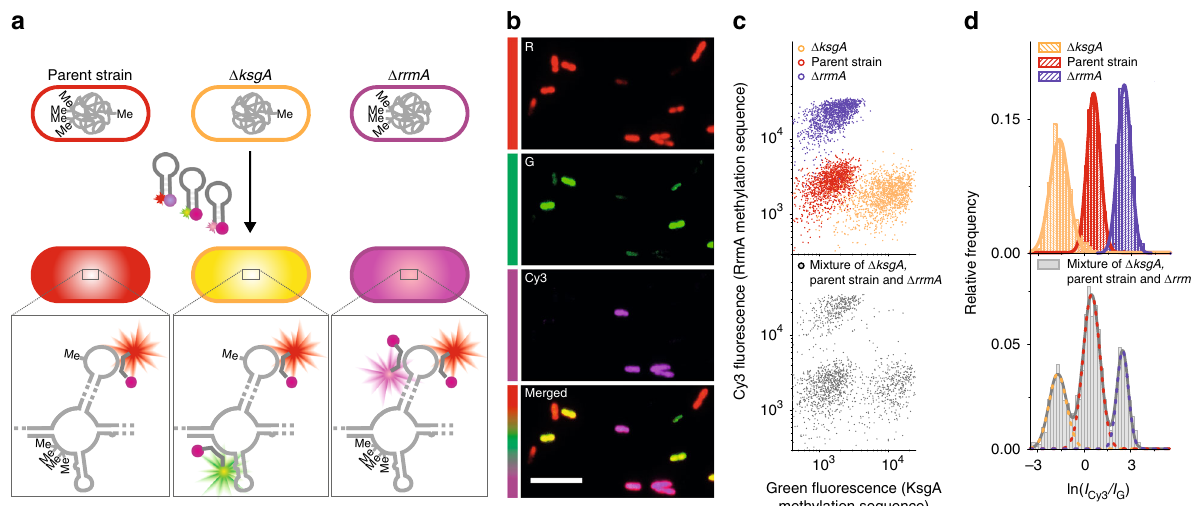
Fig. 4 Multiplexed detection of rRNA methylations with MR-FISH. a Multiplexed assay for two rRNA methylations, using three Molecular Beacons, staining an unmethylated portion of the 23S rRNA (Alexa Fluor 647-labeled), the KsgA methylation sequence (Alexa Fluor 488-labeled) and the RrmA methylation sequence (Cy3-labeled). Three strains of E . coli are used: one expressing active KsgA and RrmA (parent strain), one mutant strain with the KsgA methyltransferase deleted from its genome ( Δ ksgA ) and another mutant strain with the RrmA methyltransferase deleted from its genome ( Δ rrmA ). b False-colored fl uorescence images of a mixture of parent strain, Δ ksgA and Δ rrmA E . coli stained with the cocktail of Molecular Beacons. Scale bar: 10 μ m. c Scatter plots of green and Cy3 fl uorescence intensities of parent strain ( n = 1362 cells), Δ ksgA ( n = 1411 cells) and Δ rrmA ( n = 1288 cells) bacteria assayed separately and in a mixture ( n = 1659 cells). d Log-normally distributed ratios of Cy3 fl uorescence intensity ( I Cy3 ) to green fl uorescence intensity ( I G ) of bacteria stained by MR-FISH in ( c )